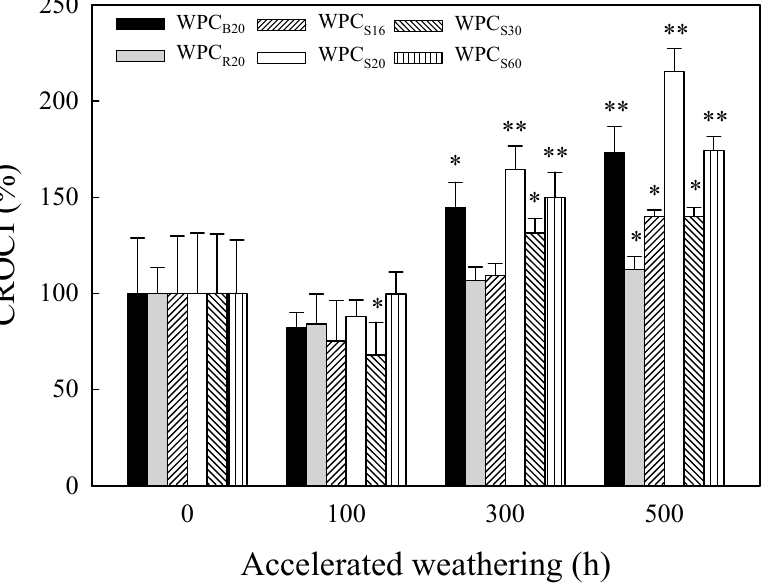
Figure 5. The CROCI values of various WPCs before and after xenon arc accelerated weathering for 100, 300, and 500 h. Values are mean ± SD ( n = 5). *: p < 0.05; **: p < 0.01 (one-tailed test) compared to the unweathered WPC.